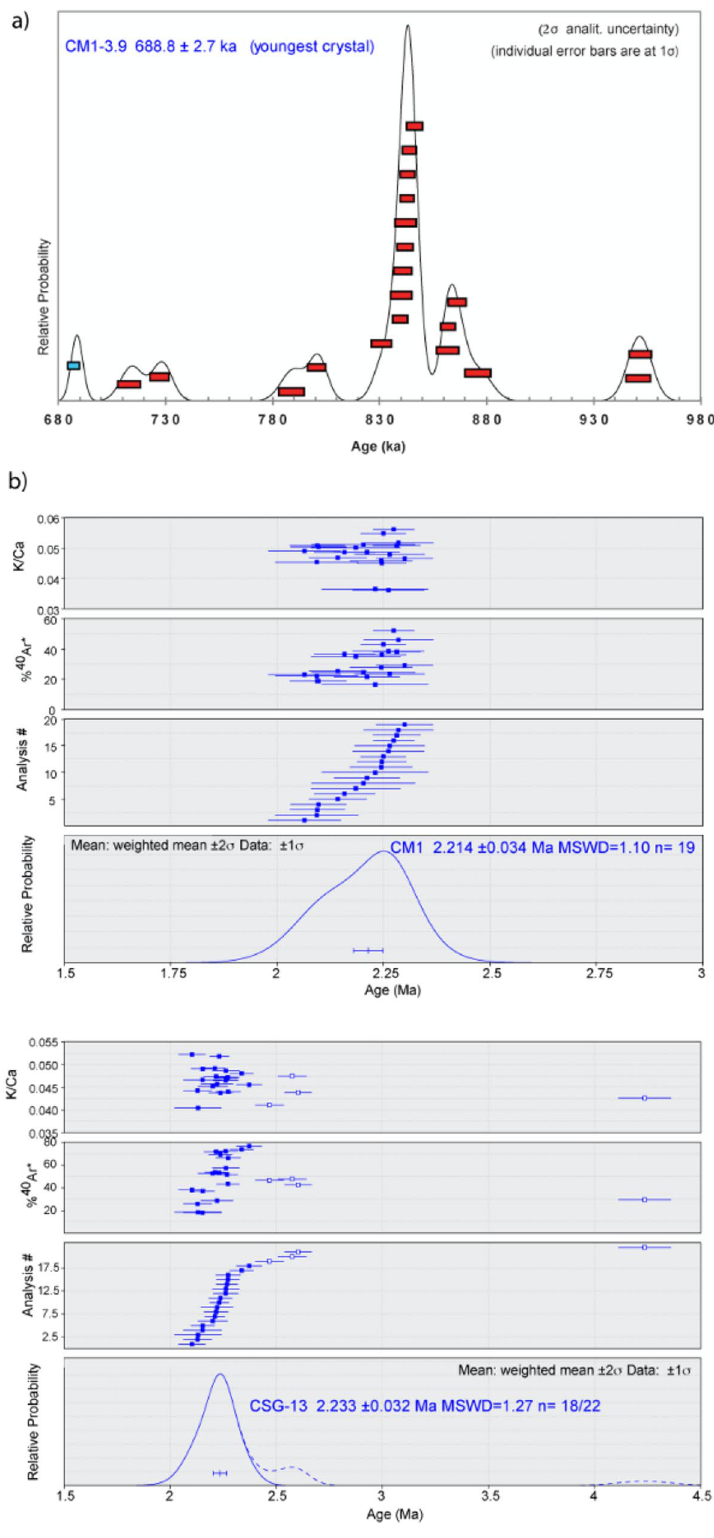
Figure 7. Relative probability diagrams showing the results of the 40Ar/39Ar dating experiments performed at LSCE ( a ) and at the Wiscar Laboratory ( b ). Full analytical data are reported in Supplementary Material #2,